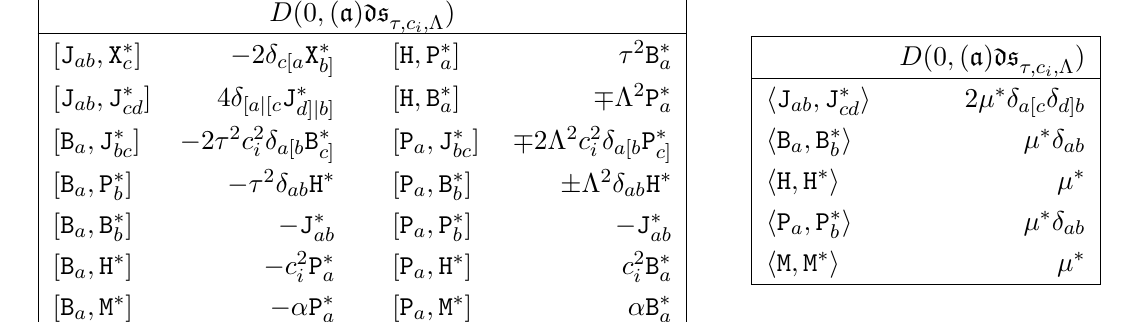
Table 9 . Additional commutation relations to table 4 for the coadjoint extension of the AdS (upper sign) and dS (lower sign) algebra in D + 1 dimensions. The vector X (cid:3) B a and P a . The algebra and its metric stay regular for all possible